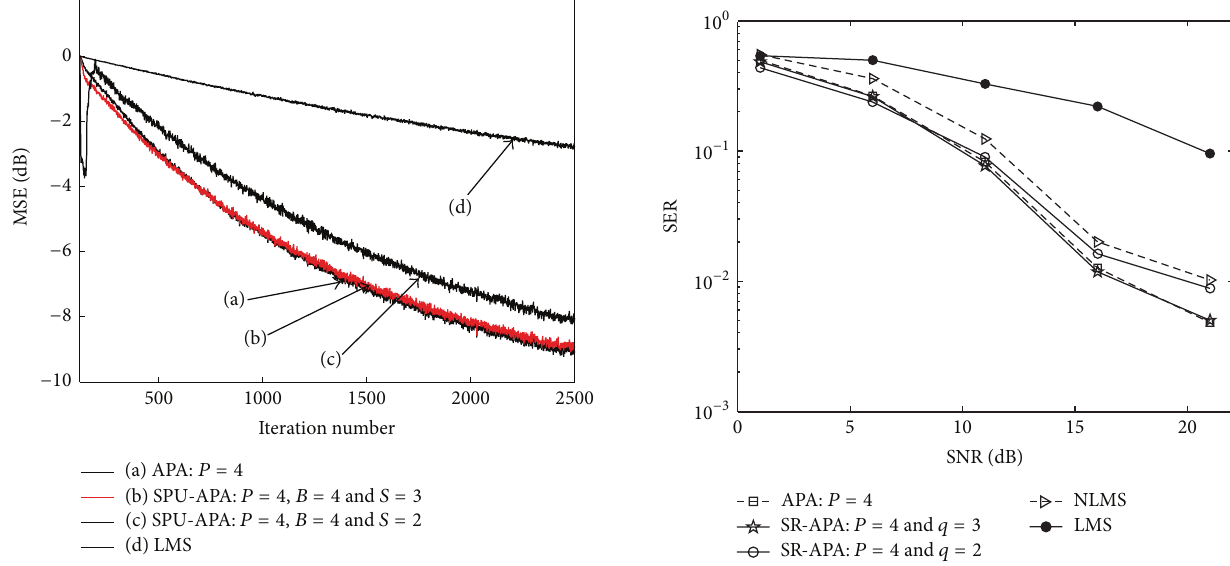
Figure 6: Symbol error rate versus SNR for APA and